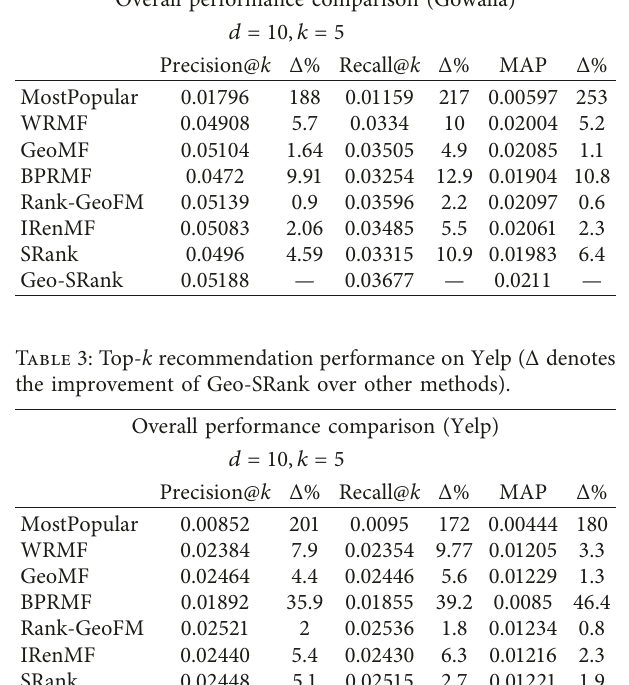
Table 2: Top- k recommendation performance on Gowalla ( Δ denotes the improvement of Geo-SRank over other methods). Overall performance comparison (Gowalla)